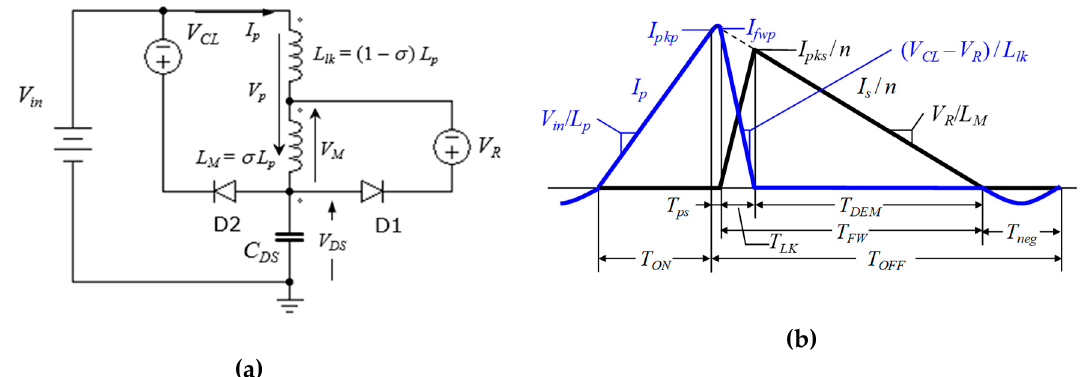
Figure 15. ( a ) Simplified equivalent circuit during off time. ( b ) Current in the real primary windings (blue trace) and in the secondary windings (black trace) .